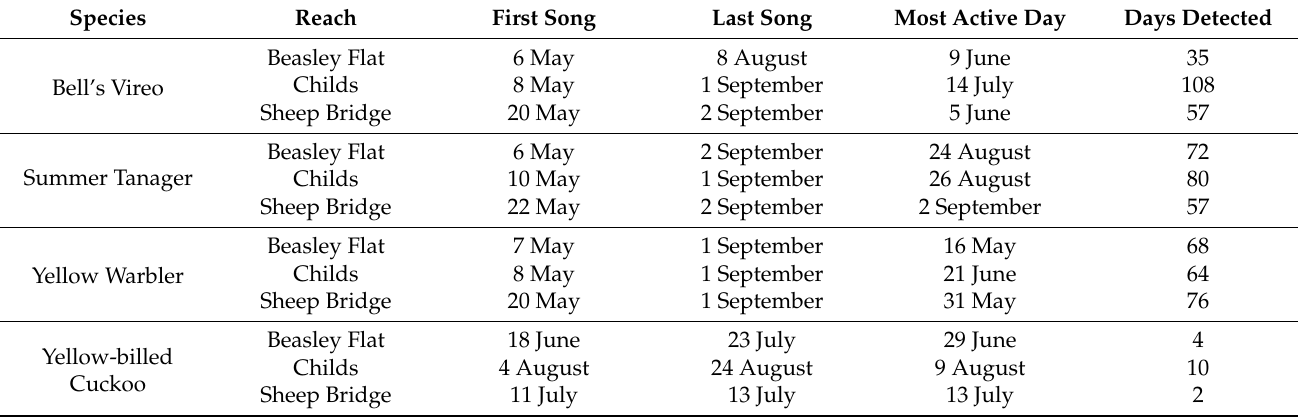
Table 1. Summary of vocal activity of four species of riparian birds from May to September 2018, Lower Verde River, Arizona (USA). Each reach had three recorders. Dates represent when songs were detected on any of the recorders. Number of days from recorders varied from 80 to 120 days (see Table S3).